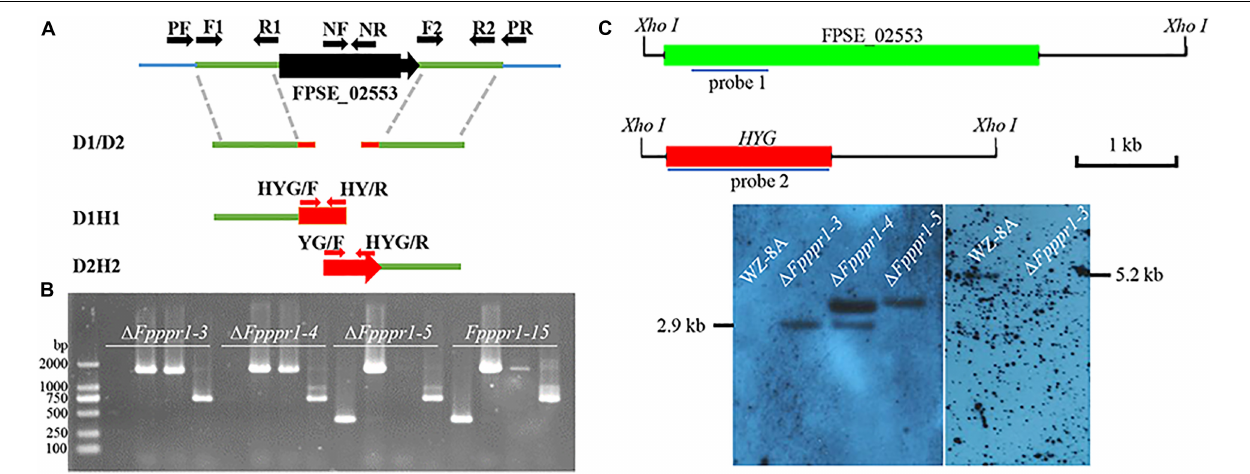
FIGURE 2 | Knockout of FpPPR1 . (A) Schematic diagram of the split marker PCR strategy. (B) Agarose gel electrophoresis of PCR products from transformants. M, DL = 2,000 bp. (cid:49) Fpppr1-3 , (cid:49) Fpppr1-4 , (cid:49) Fpppr1-5 , and (cid:49) Fpppr1-15 represent the transformants with hygromycin resistance. Each line was detected in order by the negative primer pair FpPPR1-NF/FpPPR1-NR, and the positive primer pairs FpPPR1-PF/H855R and H856F/FpPPR1-PR, and HYG-F/HYG-R, respectively, on a 1% agarose gel. (C) Southern blot hybridization analysis of the candidates. The schematic diagram on upper panel showed the cutting site of Xho I restriction enzyme in wild type (FPSE_02553) and mutant ( HYG ) genomes. The 1 kb drawing scale, probe 1 for detecting HPH , and probe 2 for detecting target gene were also listed. All genomic DNA from wild type WZ-8A, (cid:49) Fpppr1-3 , (cid:49) Fpppr1-4 , and (cid:49) Fpppr1-5 were digested with Xho I. The lower panels showed the Southern blot results with probe 1 (right membrane) and probe 2 (left membrane), respectively. A 2.9-kb fragment was observed in (cid:49) Fpppr1-3 and (cid:49) Fpppr1-4 , but (cid:49) Fpppr1-4 is multiple copies. A 5.2-kb hybridized band was only detected in wild type WZ-8A, but not in (cid:49) Fpppr1-3 using probe 1 on downstream fragment of FpPPR1 .